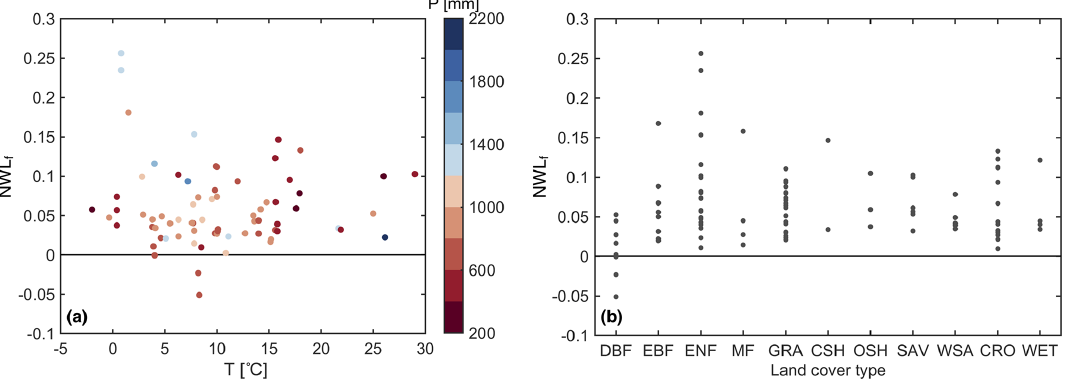
Figure 3. Relation of NWL f with (a) the mean annual temperature ( T ) and precipitation ( P ) as well as with (b) land cover type at the FLUXNET sites. Precipitation and temperature data are available for 73 of the 99 FLUXNET sites. The land cover types are deciduous broadleaf forest (DBF), evergreen needleleaf forest (ENF), evergreen broadleaf forest (EBF), mixed forest (MF), grassland (GRA), closed shrubland (CSH), open shrubland (OSH), savanna (SAV), woody savanna (WSA), cropland (CRO), and wetland